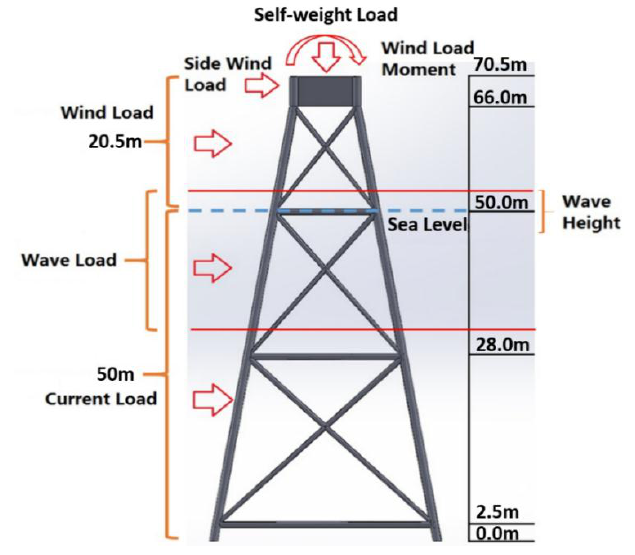
Figure A16. Schematic of the simplified (2D) loads for jacket substructures.